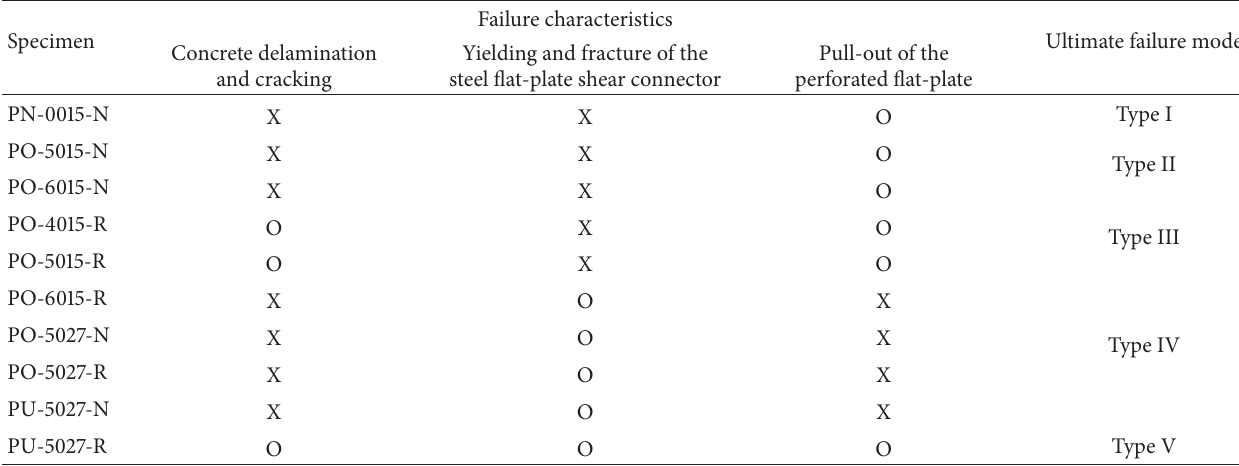
Table 4: Failure modes of test